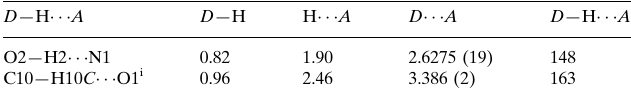
Hydrogen-bond geometry (A˚ , (cid:2)